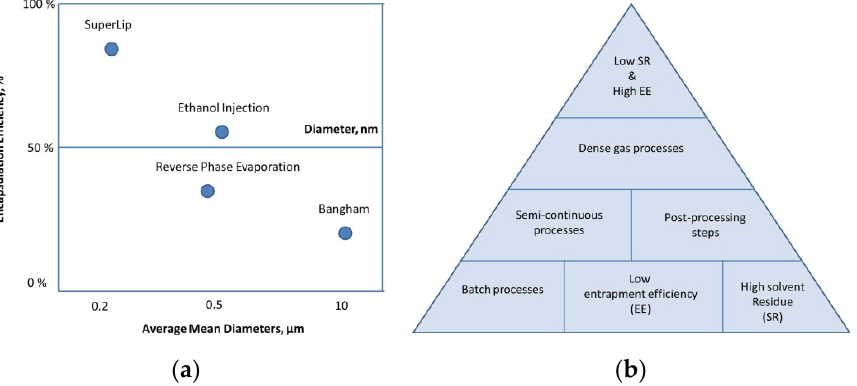
Figure 1. ( a ) A features map of encapsulation efficiencies and mean size of liposomes produced using different techniques. ( b ) Pyramid sketch of the main advantages and disadvantages of liposomes production (SR: Solvent Residue, EE: Encapsulation Efficiency).